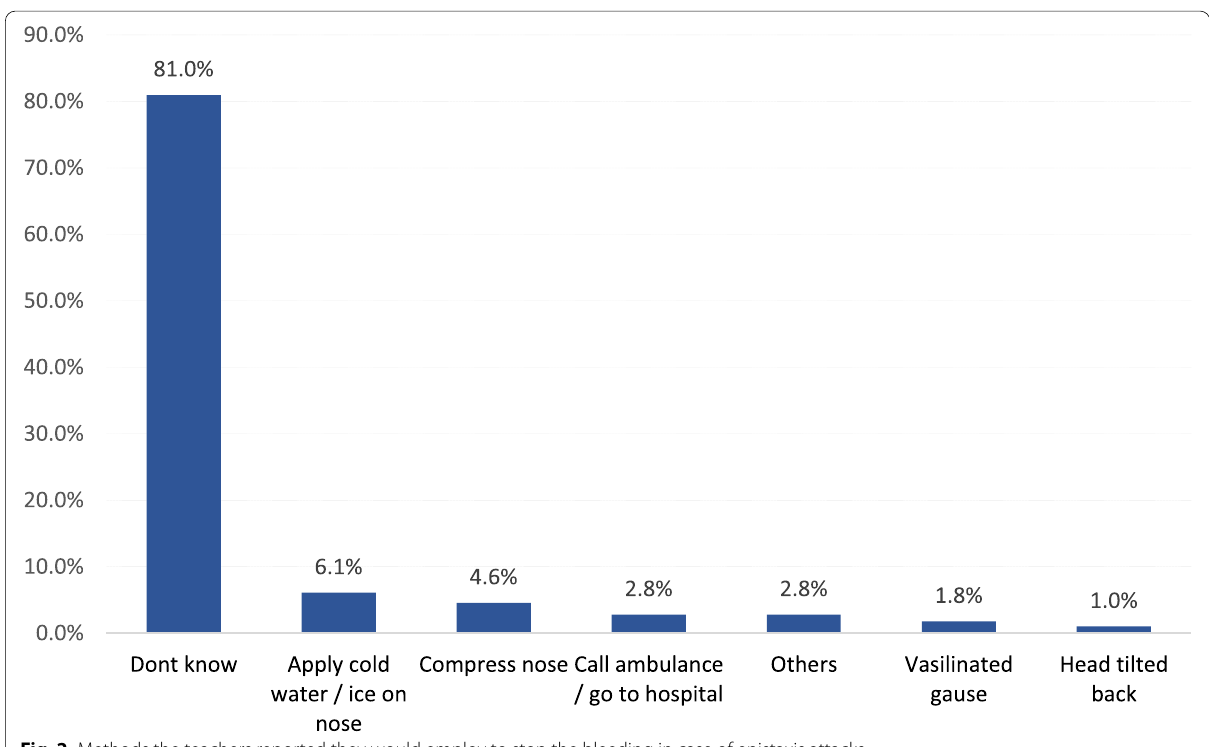
Fig. 2 Methods the teachers reported they would employ to stop the bleeding in case of epistaxis